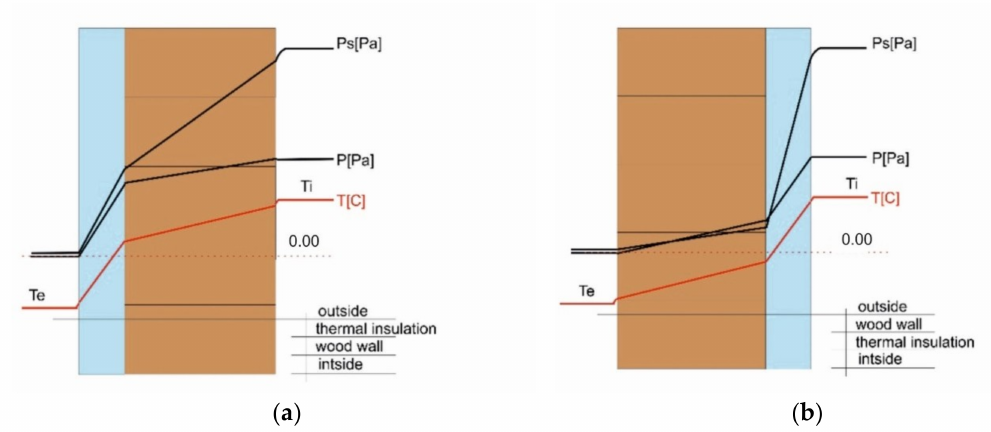
Figure 1. Temperature and vapour pressure charts, calculated as per PN-EN ISO 13788: 2013-05 [26] for applying thermal insulation to an external wall (no condensation) from inside ( a ) and outside ( b ) (problems with inter-layer condensation). Psi—saturated vapour pressure, P—actual vapour pressure, Ti—indoor temperature, Te—outdoor